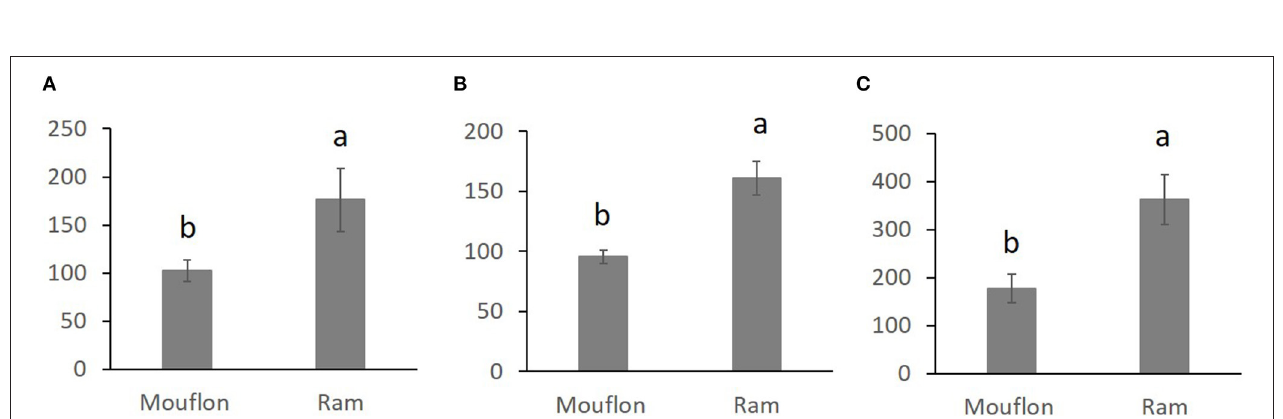
FIGURE 2 | Stress resistance factor (SR) (mean ± SE) for low levels of ROS after refrigeration at 15 ◦ C during 20h (A) and after refrigeration at 15 ◦ C during 20h and subsequent incubation at 38.5 ◦ C for 2h (B) SR for high levels of ROS after refrigeration at 15 ◦ C during 20h and subsequent incubation at 38.5 ◦ C for 2h (C) in mouflon and ram sperm samples. Means within different letters are significantly different ( p < 0.05) between